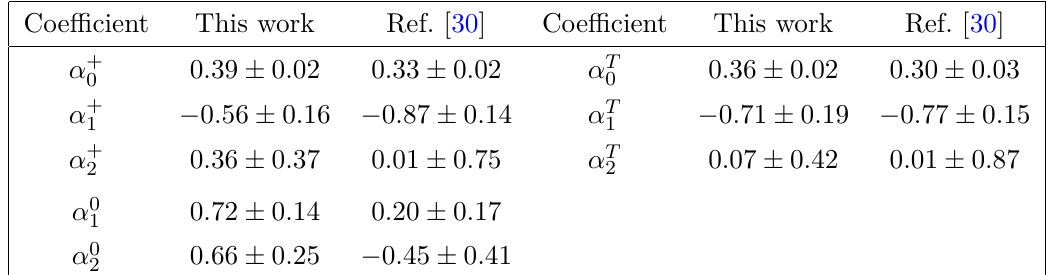
Table 9 . Posteriors of the B → K local FFs fit. We have used the exact relation (A.9) to reduce the number of parameters to 8. The posterior distribution is accurately described with a single mul- tivariate Gaussian distribution, whose parameters are given in the ancillary file BToK-local.yaml . We compare our results to those of ref.